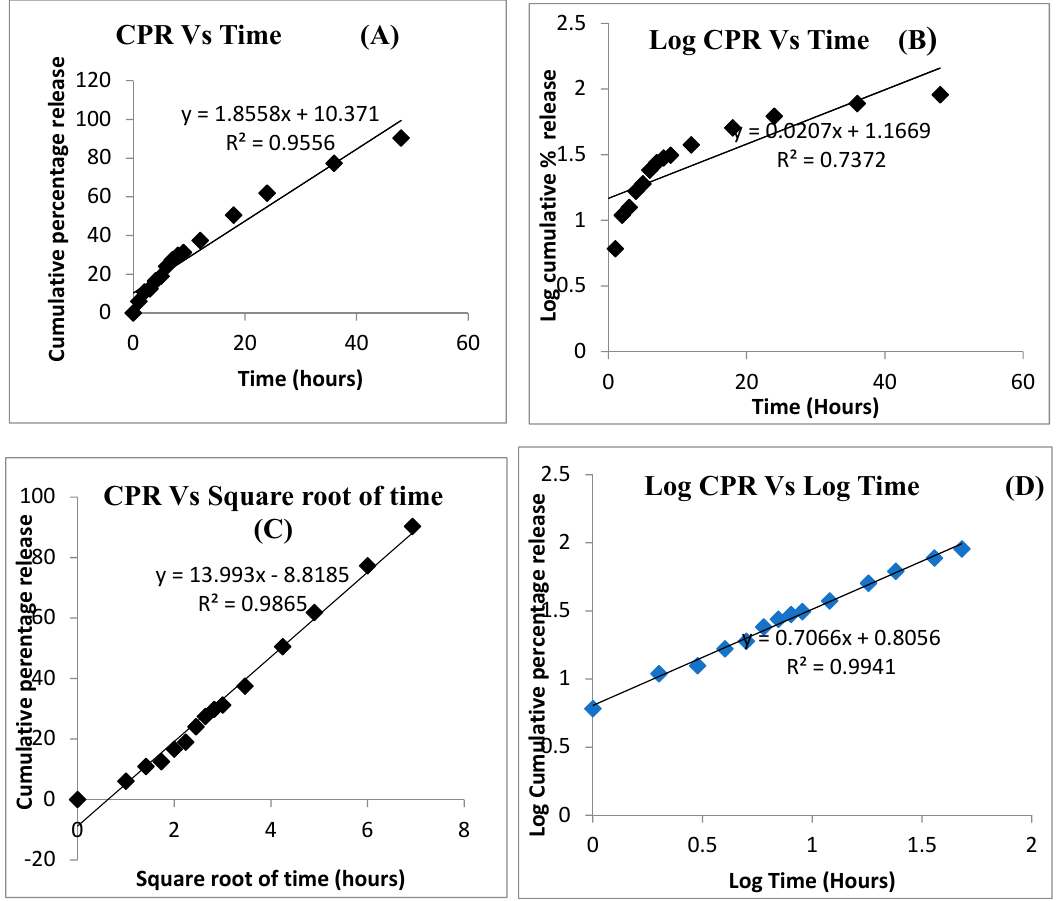
Figure 6. Kinetic assessment of drug release from T f ‐ conjugated PLGA NPs using various kinetic Figure6. KineticassessmentofdrugreleasefromT f -conjugatedPLGANPsusingvariouskineticmodels: models: ( A ) zero ‐ order kinetics, ( B ) first ‐ order kinetics, ( C ) Higuchi’s model, and ( D ) Korsmeyer– ( A ) zero-order kinetics, ( B ) first-order kinetics, ( C ) Higuchi’s model, and ( D ) Korsmeyer–Peppa’s Peppa’s model.